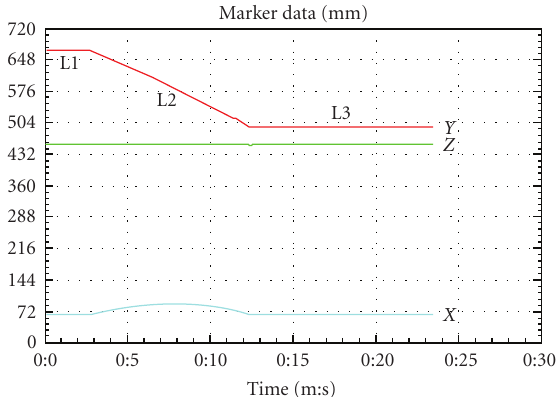
Figure 7: Curve for the slave robot’s end during the cooperation and fine